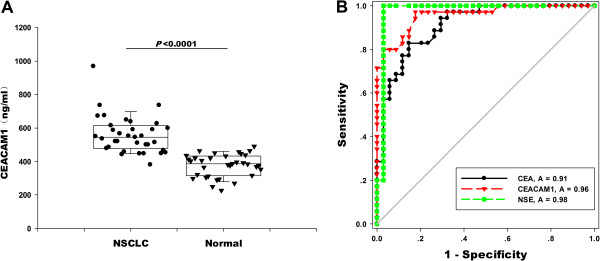
Individual CEACAM1 serum levels and receiver operator characteristic curves for NSCLC patients and normal controls. (A) The serum CEACAM1 in patients with NSCLC and normal controls are plotted as a distribution (P < 0.001). (B) ROC curves generated from the serum CEACAM1, CEA and NSE of 35 patients with NSCLC. The areas under the curves are 0.96, 0.91 and 0.98 for CEACAM1, CEA and NSE, respectively (P < 0.05).